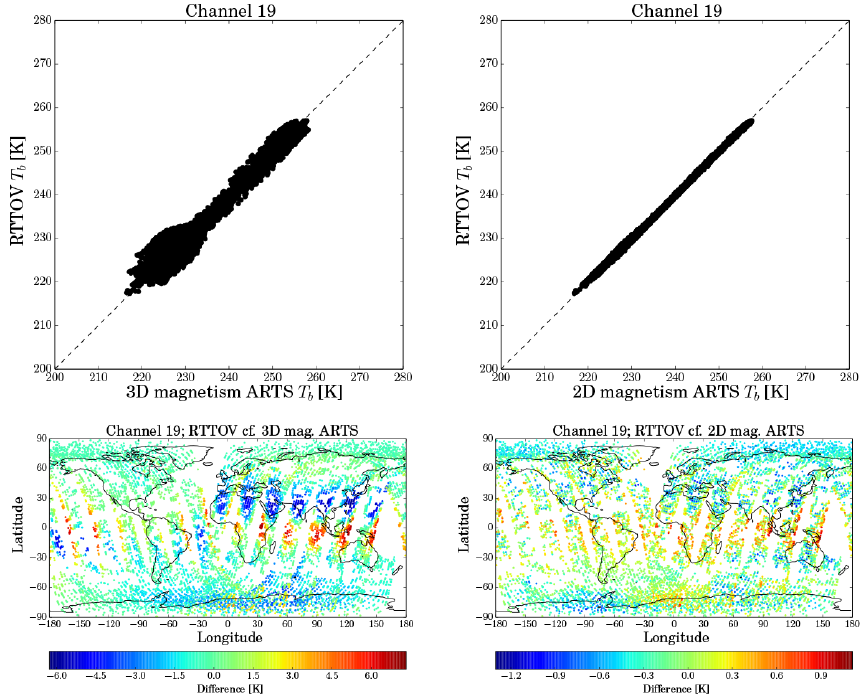
Figure 6. Channel 19 comparison of RTTOV and ARTS simulations. The upper row contains spread plots for RTTOV simulations on the y axis and for ARTS simulations on the x axis. The lower row contains the above spread plots mapped onto the surface of Earth to where the corresponding SSMIS measurement was done. In these maps, the magnitudes of the difference between the simulations are shown in color. The color corresponds to ARTS minus RTTOV. The left column shows RTTOV compared to ARTS simulations with a three-dimensional magnetic field and the right column shows RTTOV compared to ARTS simulations with a two-dimensional magnetic field. It is important to note that the color scale changes between the maps; this has been done to highlight all model differences, which are discussed in the